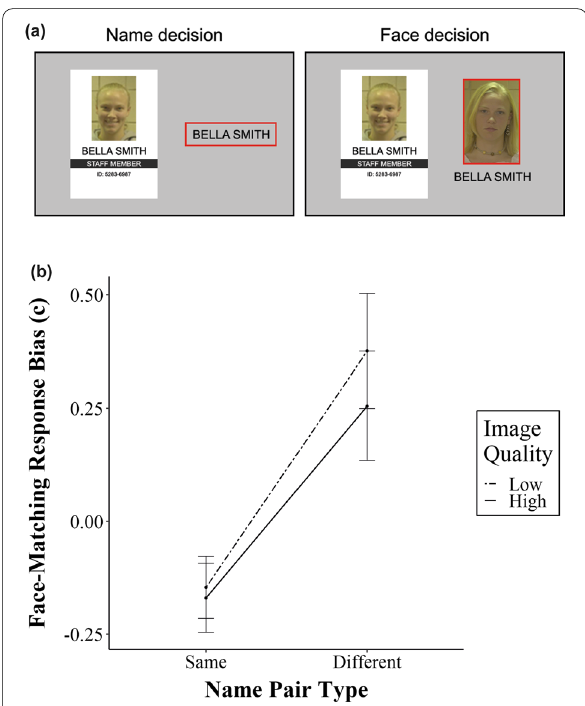
Fig. 4 a A visual example of the red outline that participants viewed in Experiment 3 for name and face decisions within each trial. The outline was added to the “database” information to remind participants of which matching decision they were required to complete at each stage of the trial. b Experiment 3 criterion scores across levels of name pair type and image quality. All error bars represent standard